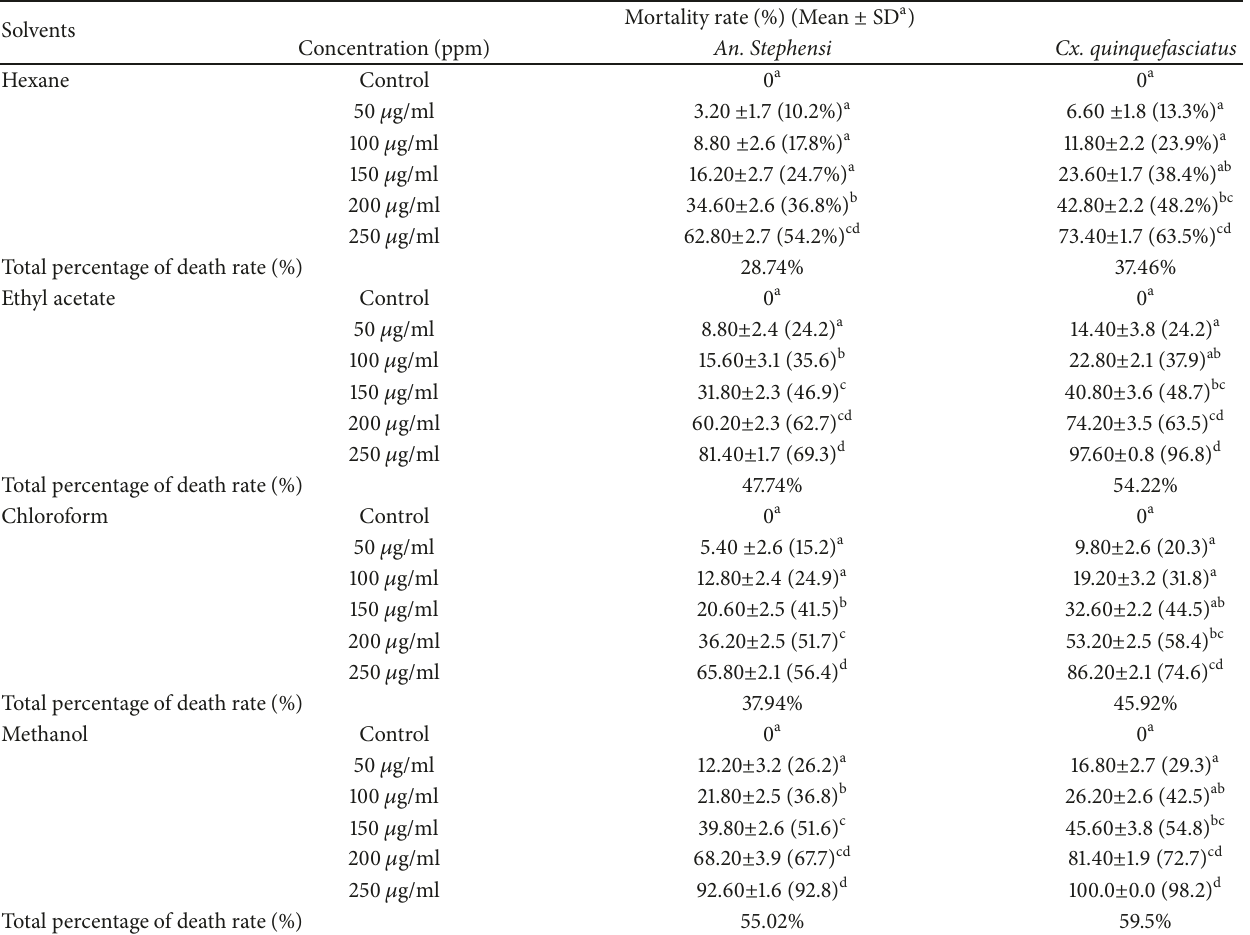
Table 1: Percentage mortality of mosquito larvae of An. stephensi and Cx. quinquefasciatus exposed to different concentrations of different solvent leaf extracts of E. variegata